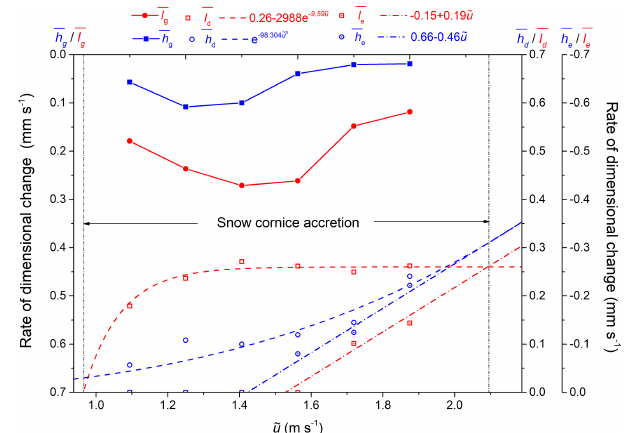
Figure 6. Averaged growth rates, erosion rates, and deposition rates in length and thickness under different wind conditions. The fitted functions are plotted as dashed lines.